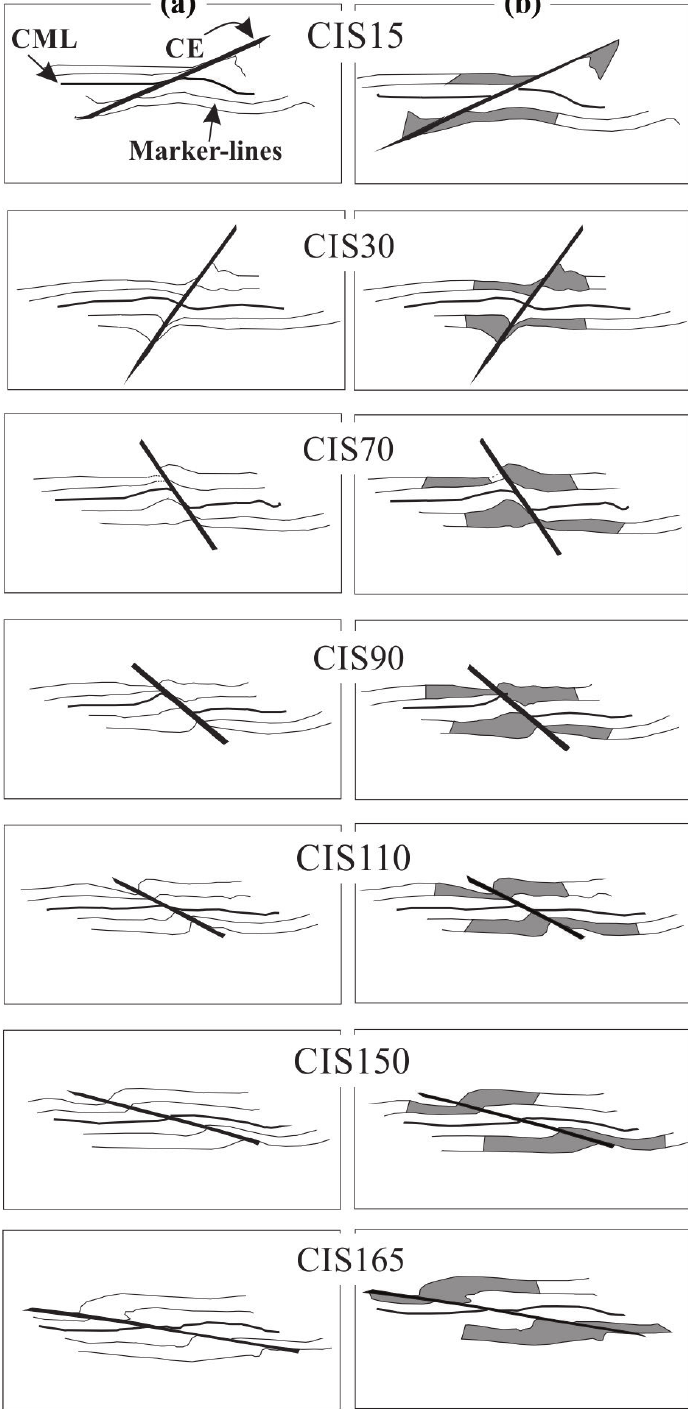
Figure 6 - Summary of our final flanking structures. In ( a ), we present marker lines only. In ( b ), we highlight the thickening and thinning (grey) domains. The heights of the figures correspond to 15 cm. CE = cross-cutting element; CML = central marker